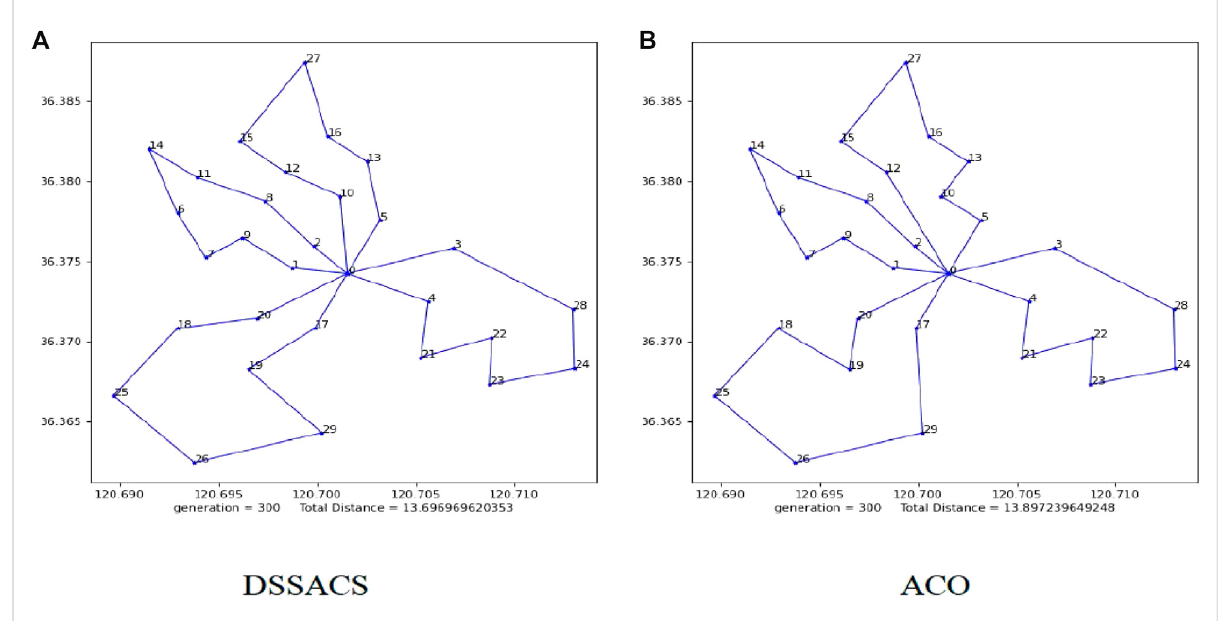
FIGURE 9 Paths of DSSACS (A) and ACO (B).